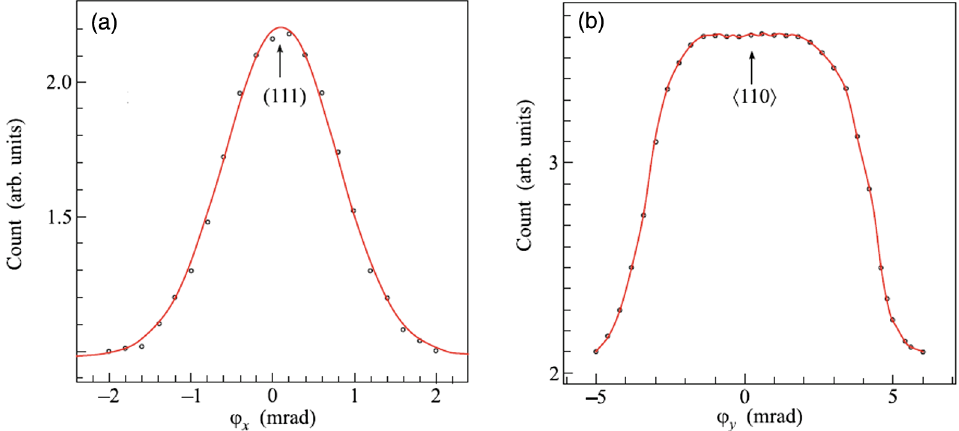
FIG. 4. Count rate of the calorimeter C 1 versus the ( а ) horizontal and (b) vertical